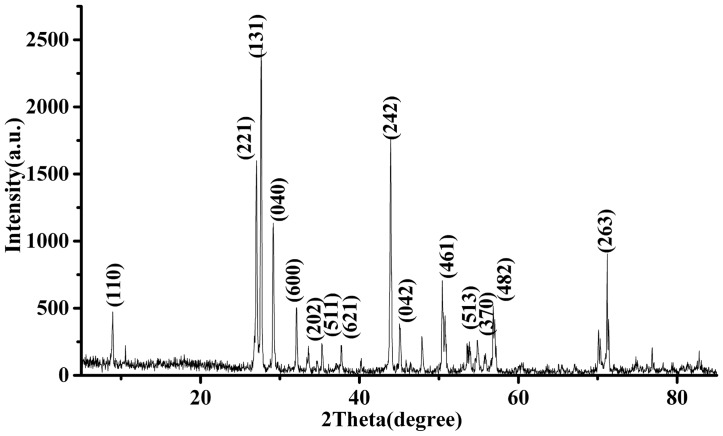
XRD pattern of Yb3+:KBaGd(MoO4)3 crystal at room temperature.